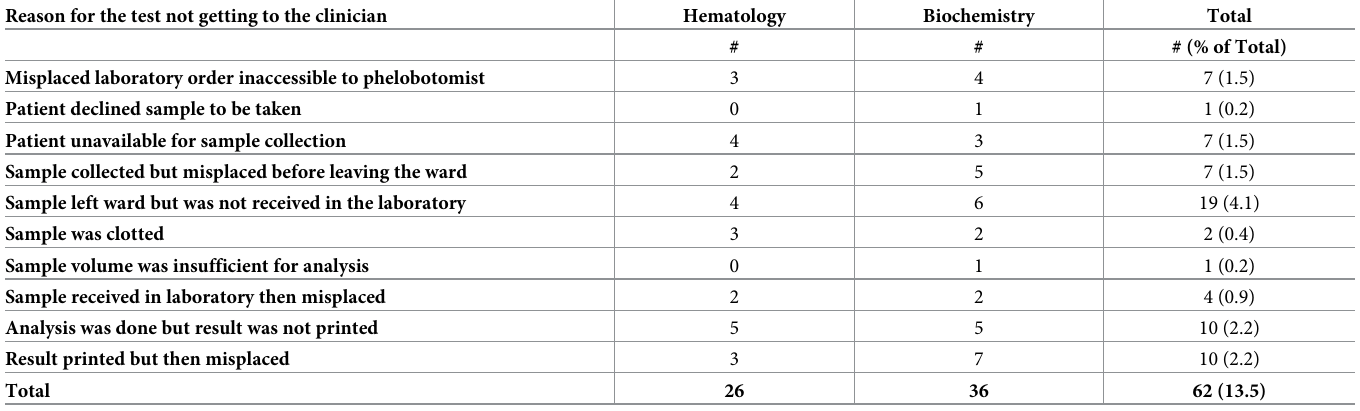
Table 1. List of tests misplaced in the